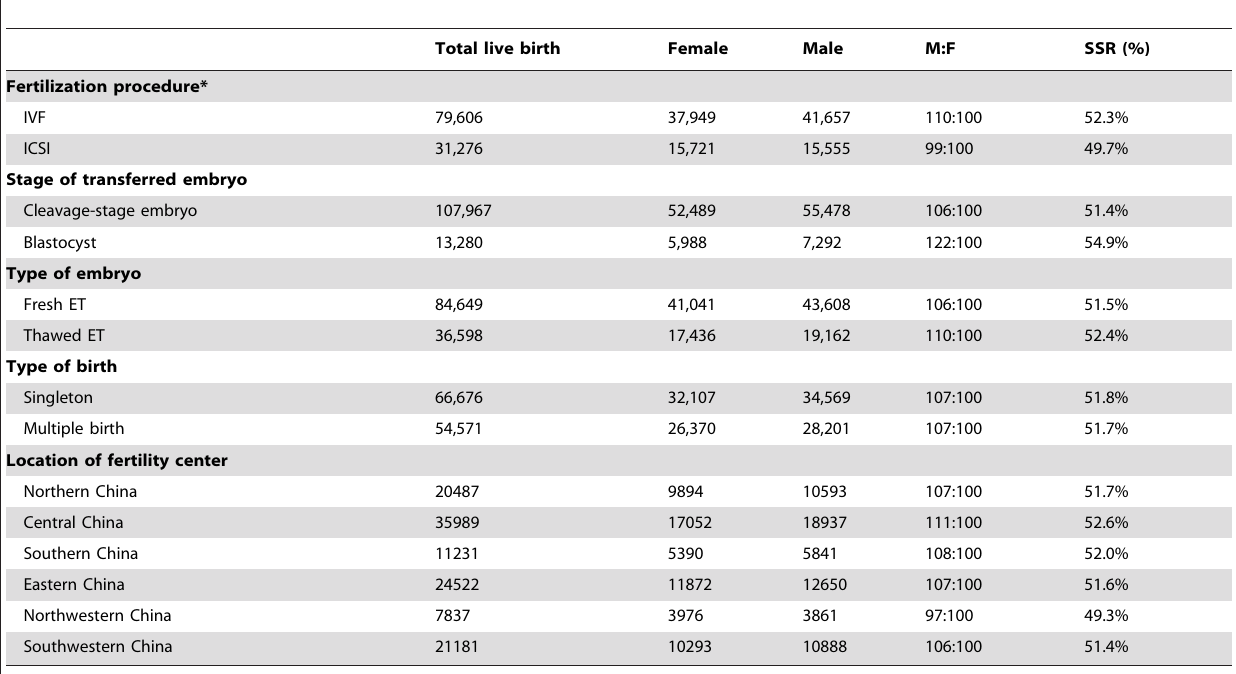
Table 1. Sex ratio of live birth offspring by different ART procedures and type of birth.